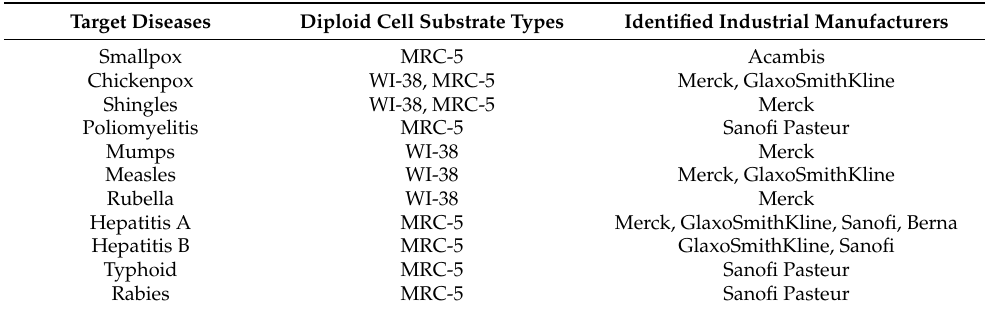
Table 4. Notable vaccine product types for which the industrial manufacturers are known to have used the WI-38 1 and the MRC-5 2 diploid-cell sources in the development and production activities [2]. ATCC, American-type culture collection; MRC, medical research council; WI, Wistar